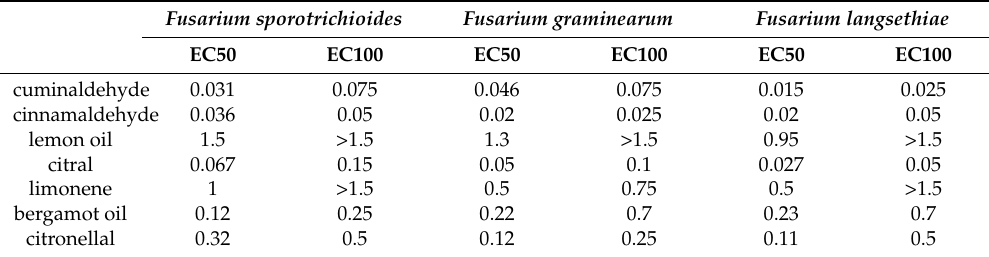
Table 1. EC 50 * and EC 100 ** (expressed as mL of compounds per 100 mL medium) of the seven products on in vitro growth of F. sporotrichioides, F. graminearum and F. langsethiae